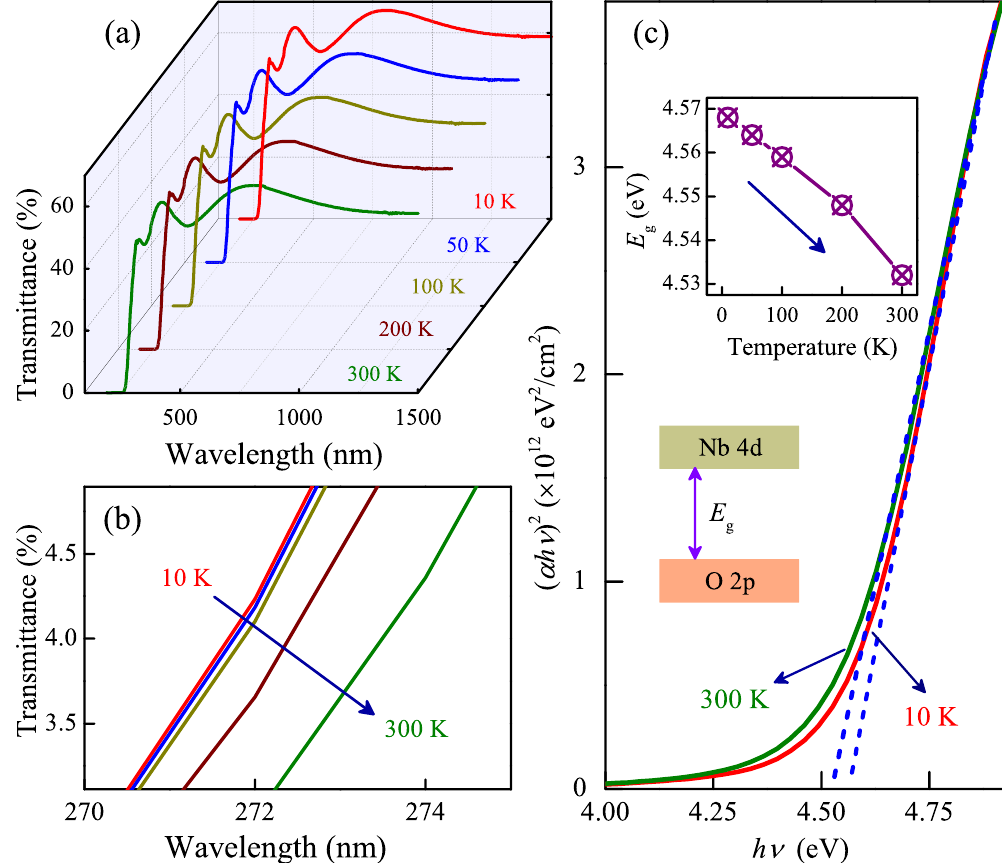
Figure 5. ( a ) Temperature dependent transmittance spectra of KN-quartz film. ( b ) An enlarged spectral region near the absorption edge for KN-quartz film at different temperatures. ( c ) Plots of ( α h ν ) 2 ν s . the photon energy for the estimation of direct optical band gap energies for KN-quartz film at 10 and 300 K. Note that the inset in ( c ) is the temperature dependent E g of KN-quartz film and the schematic representation of the electronic band structure of